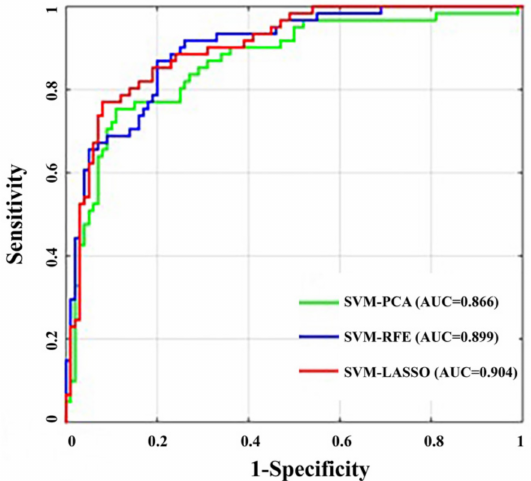
Figure 5. The ROC curves of different models for glioma grading. AUCs of AVM models for glioma grading was 0.866 by SVM-PCA, 0.899 by SVM-RFE and 0.904 by SVM-LASSO. Table 5. The performance of different models for glioma grading. AUC Accuracy Sensitivity Specificity F1